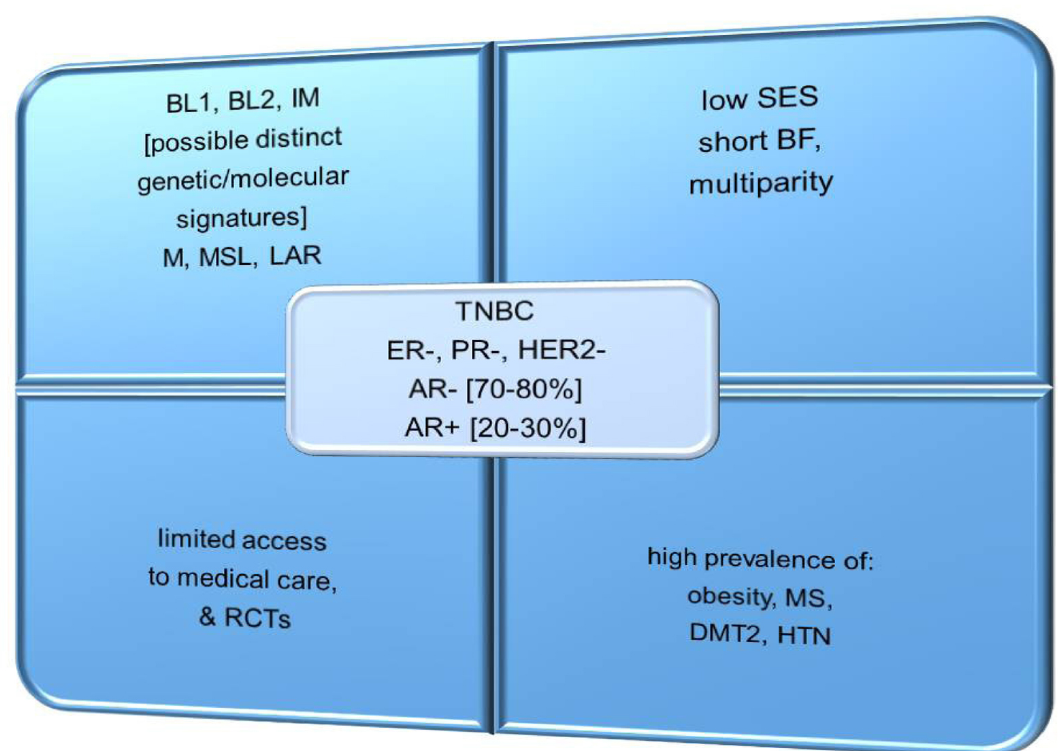
Figure 1. Common features of TNBC in AA vs. EA women. IM: immunomodulatory; M: mesenchymal; MSL: mesenchymal stem-like; BF: breastfeeding; RCTs: randomized controlled trials; SES: socio-economic status